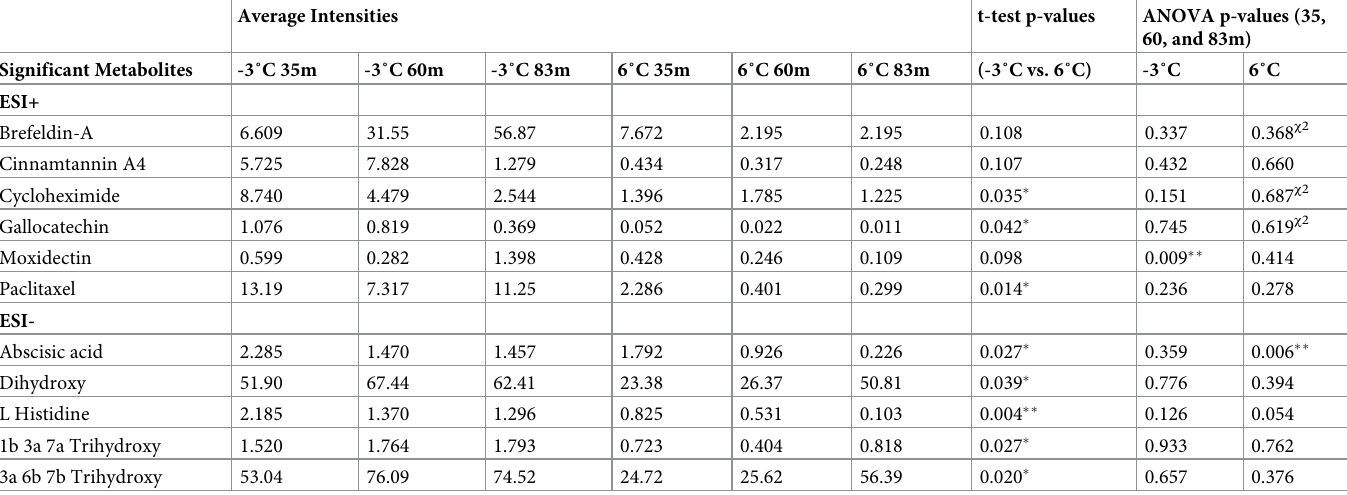
Table 1. P-Values for paired samples Wilcoxon t-test comparing significant metabolites at different temperatures (-3˚C vs. 6˚C) and ANOVA comparing the signif- icant metabolites at 35m, 60m, and 83m at both temperatures respectively. Average